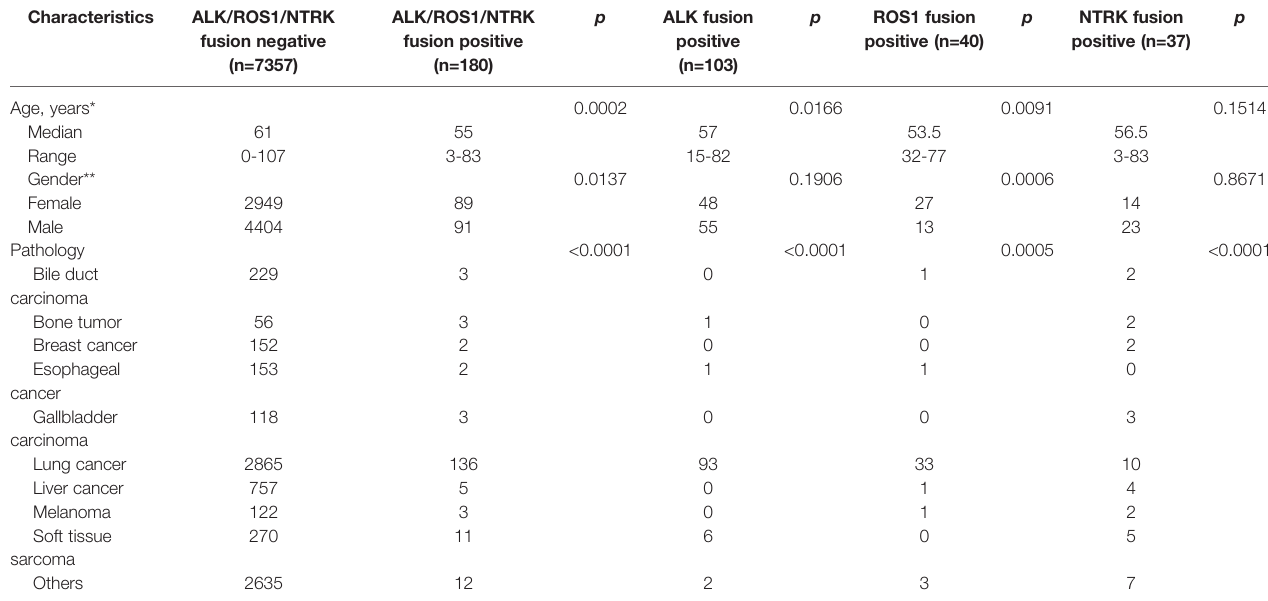
TABLE 1 | Patients ’ characteristics according to the presence or absence of ALK , ROS1 , and NTRK fusions.